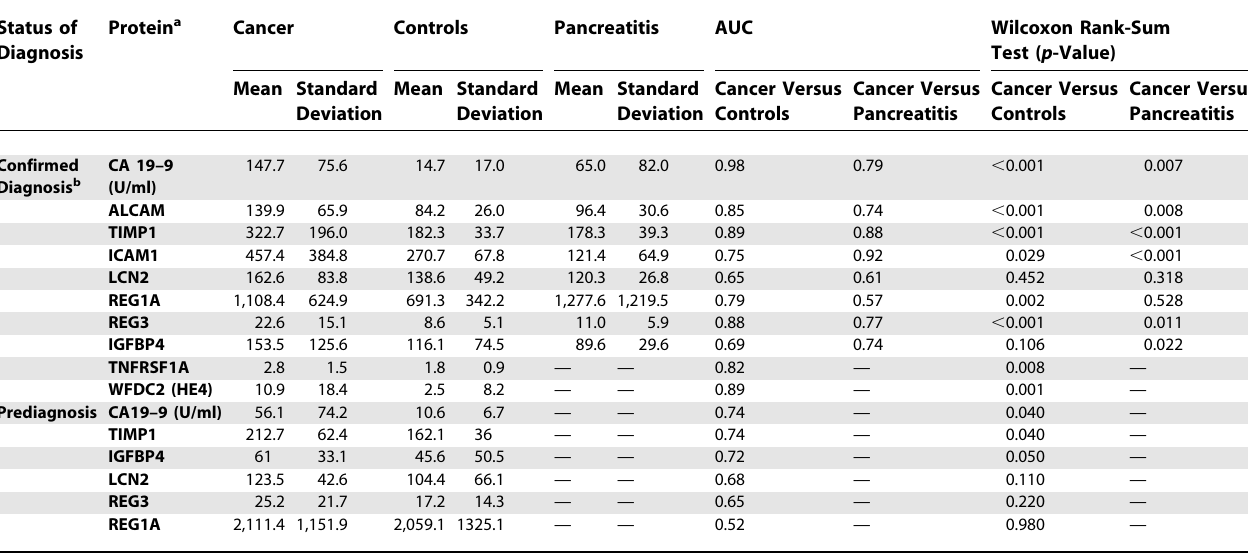
Table 2. ELISA Analysis of Up-Regulated Proteins in Pancreatic Cancer Sera and Prediagnostic Sera Status of Protein a Cancer Diagnosis